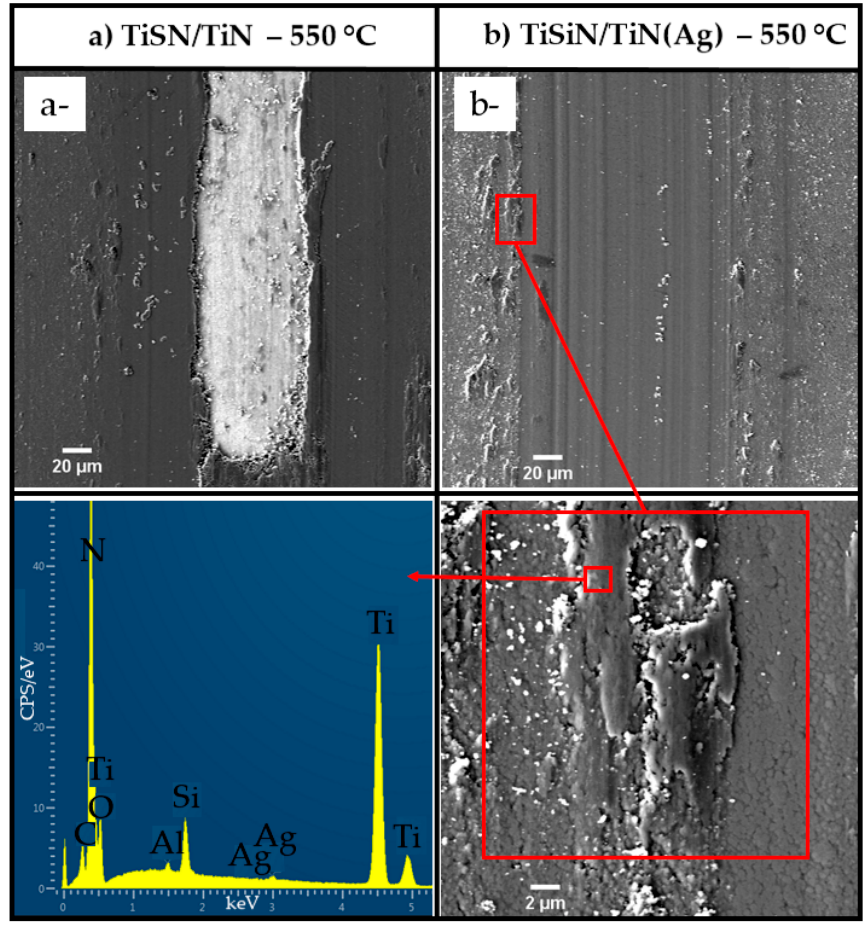
Figure 5. SEM micrographs of the wear tracks of the ( a ) reference and ( b ) Ag-alloyed coatings tested at 550 °C against Al 2 O 3 balls. The magnification of the wear debris on the wear track of the Ag-doped coating; the corresponding EDS spectrum of those wear debris is plotted too.